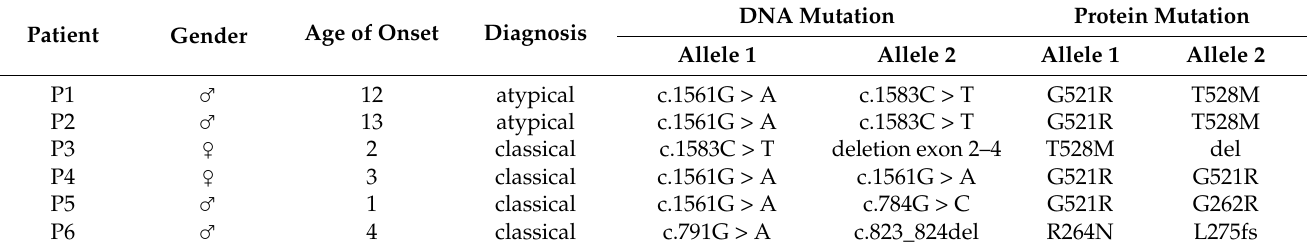
Table 1. Clinical and genetic data of PKAN patients. The DNA mutations refer to the NCBI Reference Sequence: NM_153638.3 (pantothenate kinase 2 mRNA transcript variant 1). In the registry “diagno- sis”, the threshold of 6 years of age at the onset of motor symptoms was chosen as only discriminant between “classical” and “atypical” and does not reflect the course of the disease. DNA